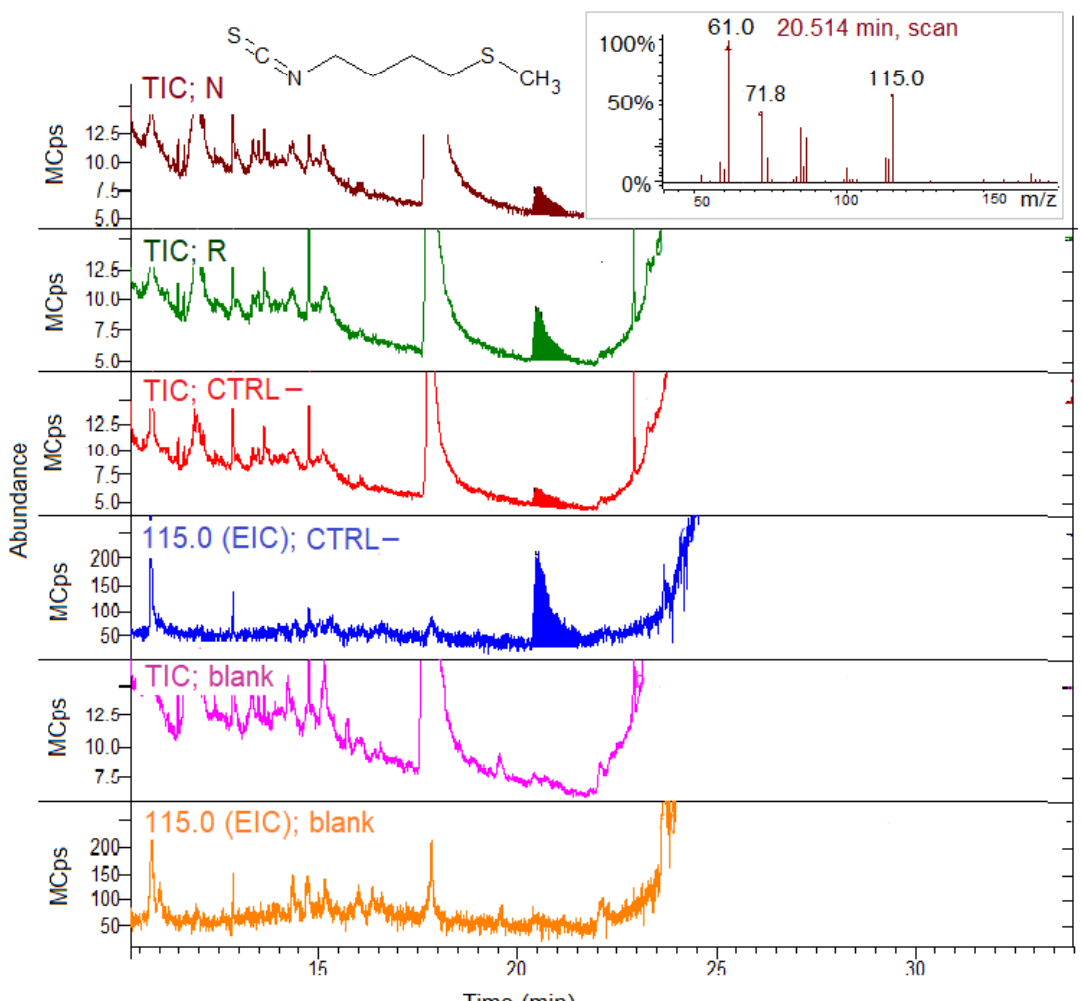
Figure 5. SPME GC–MS analysis of the concentrated midgut extracts from the bees fed on N, R and CTRL– patties for myrosinase activity detection with glucoerucin (GER) as the substrate. The blank sample chromatograms represent analysis of the buffer with GER, but without gut extracts. The chromatograms were expanded to point out the erucin isothiocyanate (ERITC) peak. TIC, total ion chromatogram; EIC; extracted ion chromatogram (115.0 m / z for ERITC). Inset: ERITC MS spectrum.